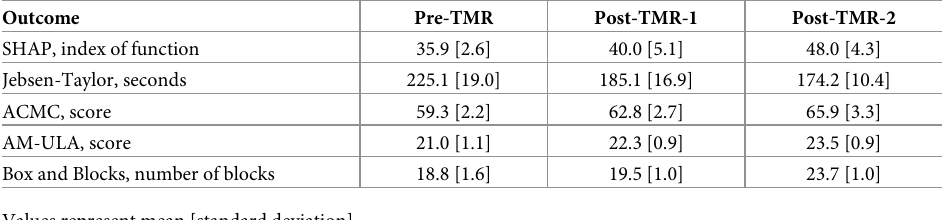
Table 3. Outcome measures following home